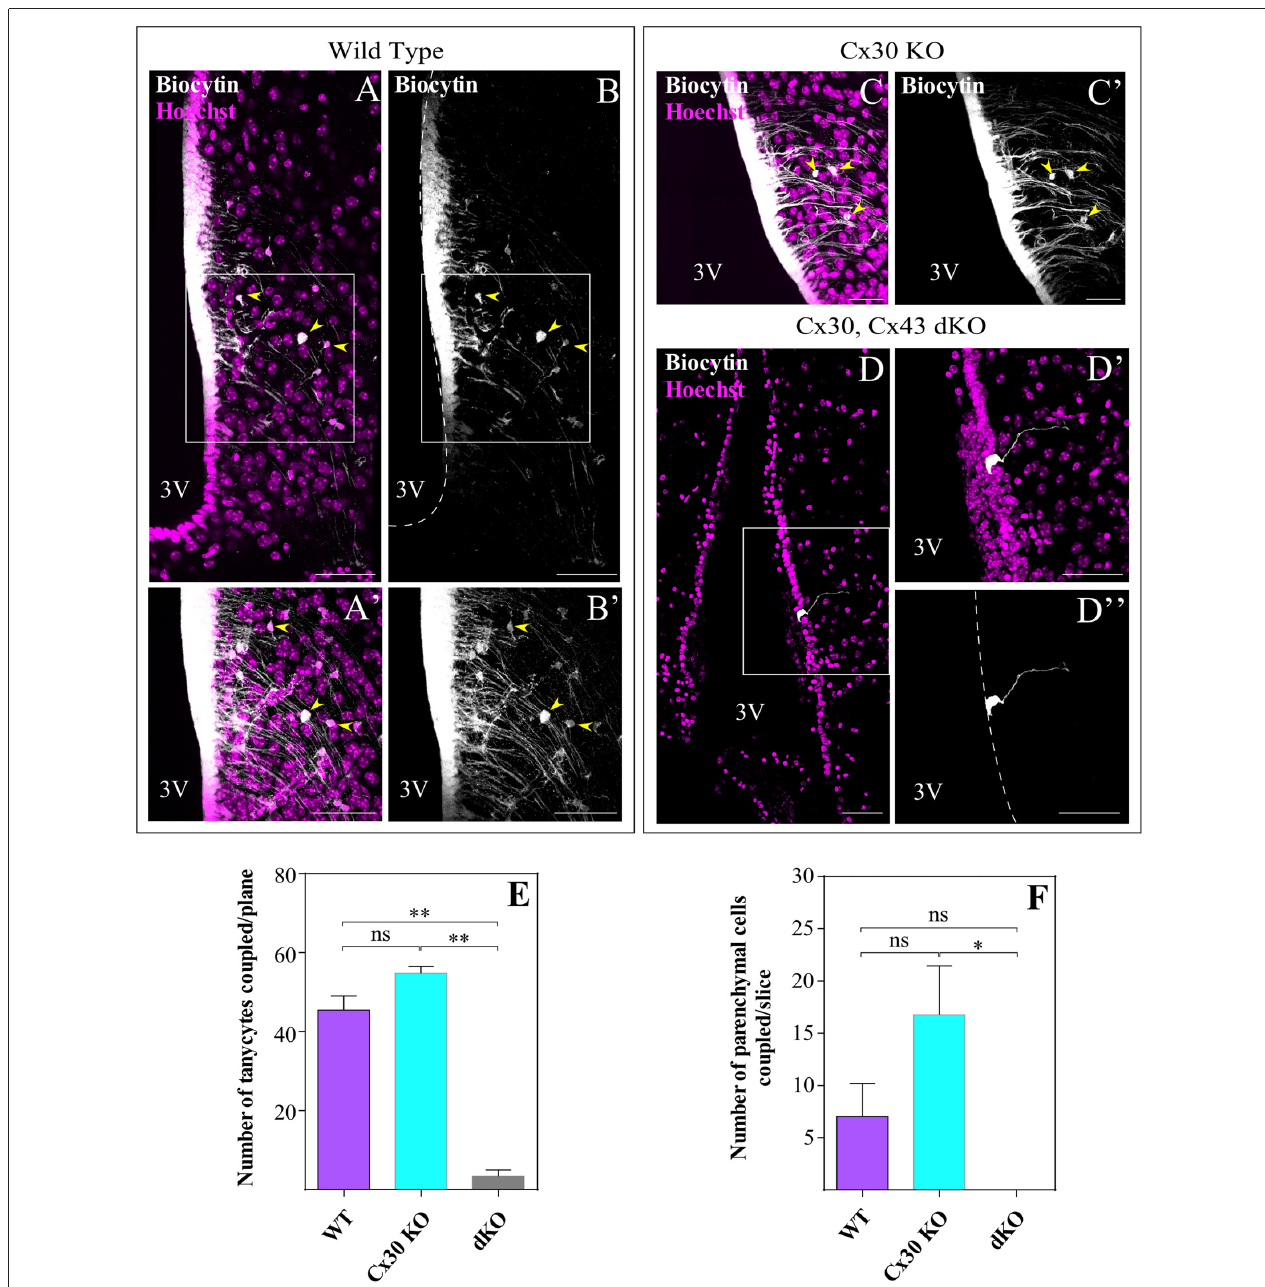
FIGURE 3 | α -tanycytes are robustly coupled with each other and with parenchymal cells through Cx43. Individual tanycytes were filled with biocytin through the pipette during the patch clamp recordings. During the recording (20 min), biocytin spread through gap junctions within α -tanycytes (A,B) and parenchymal cells (A (cid:48) ,B (cid:48) ) in hypothalamic slices from WT and Cx30 KO (C,C (cid:48) ) mice. No tracer spread was observed in the dKO mice where biocytin labeling was confined to the recorded tanycyte (D,D (cid:48)(cid:48) ) . Panels (A,B,D) represent single optical planes while (A (cid:48) ,B (cid:48) ,C,C (cid:48) ,D (cid:48) ,D (cid:48)(cid:48) ) show the areas boxed in (A,B,D) at higher magnification (projection of z-stacks of five optical planes). Yellow arrows show the parenchymal cells coupled. (E,F) The bar graphs give the proportion of biocytin-positive tanycytes and parenchymal cells, respectively. 3V, third ventricle. Scale bar (A–F) : 50 µ m ( N = 5 animals over 38 days old and at least 12 slices of each genotype; data are represented as means ± SEM; P < 0.05; one-way ANOVA, Bonferroni post hoc analysis). ∗ P < 0.05, ∗∗ P < 0.01, ns, not significant.